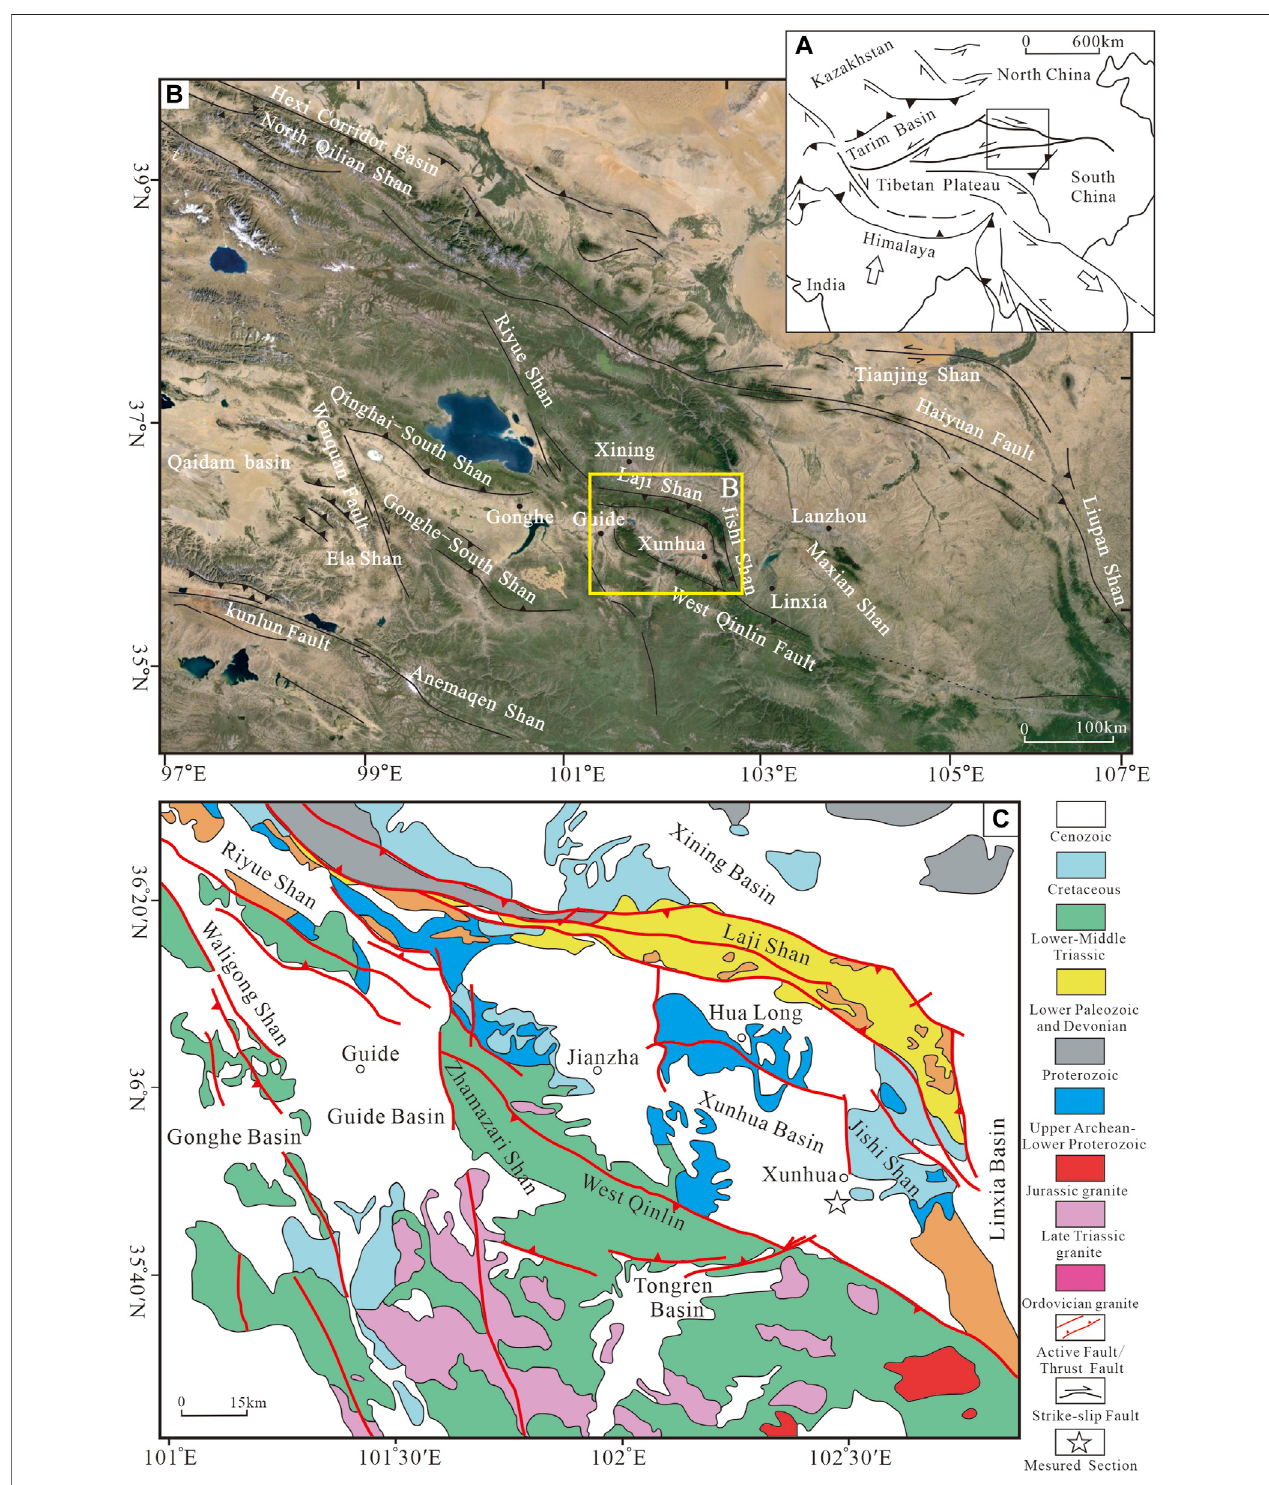
FIGURE 1 | Geological sketch maps showing the location and tectonic setting of the study area: (A) Location of the study area on Tibetan Plateau (modi fi ed from YinandHarrison,2000); (B) TectonicsketchofXunhuaBasin;and (C) DetailedgeologicalmapoftheXunhuaBasin(modi fi edfromZhangetal.,2010)andthelocationof the measured section.